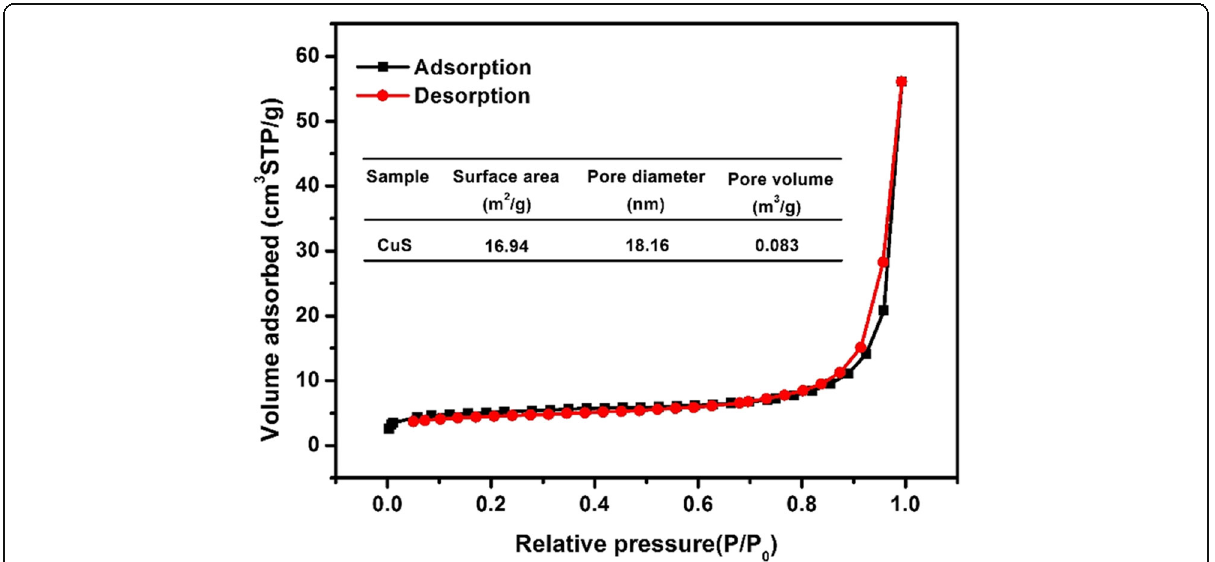
Fig. 5 N 2 adsorption-desorption curve of copper